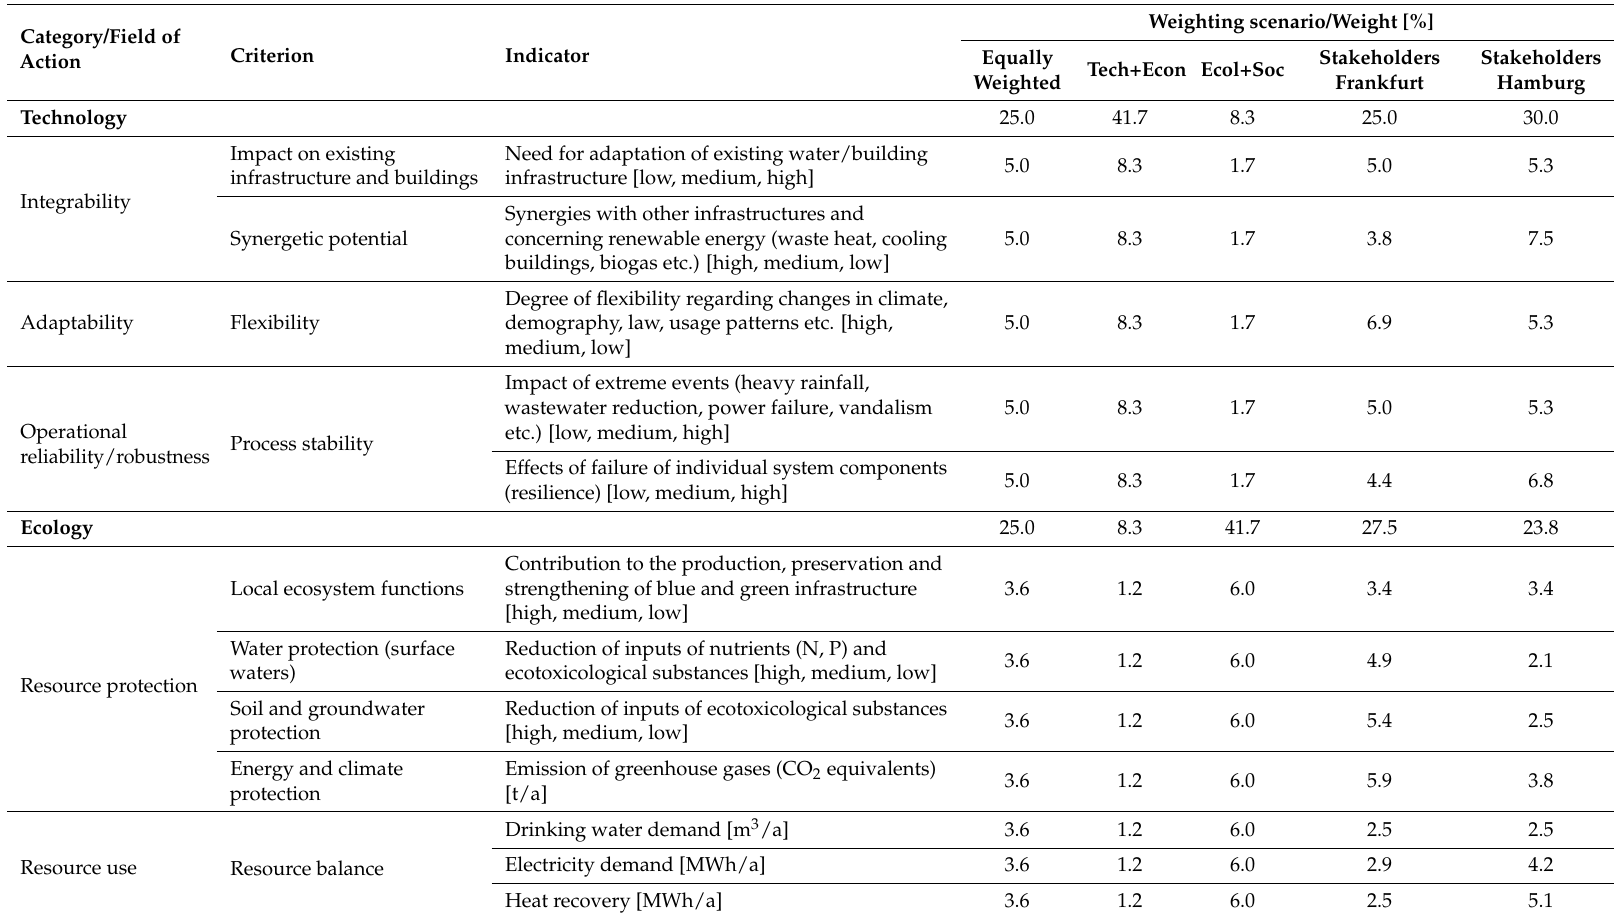
Table 2. List of assessment criteria and indicators for the impact assessment and weighting